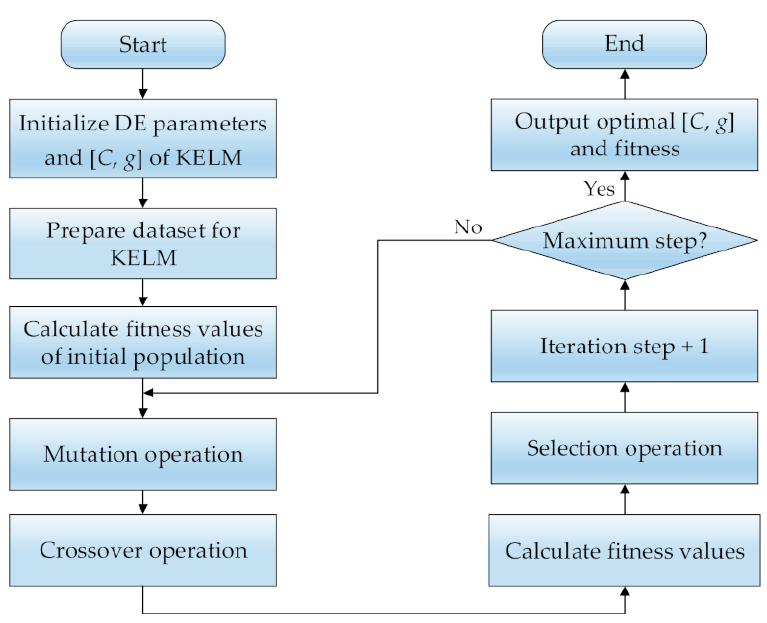
Figure 11. Workflow of DE-based KELM parameter